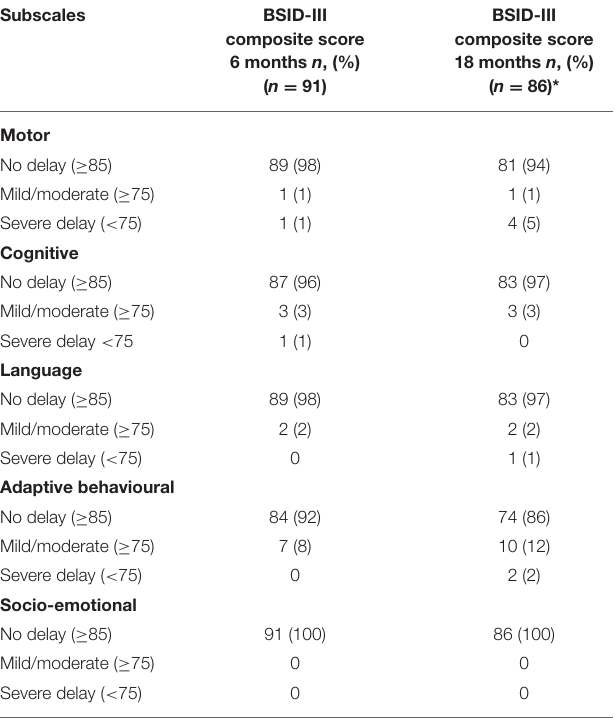
TABLE 5 | BSID-III Composite Developmental Scores at 6 and 18 months.